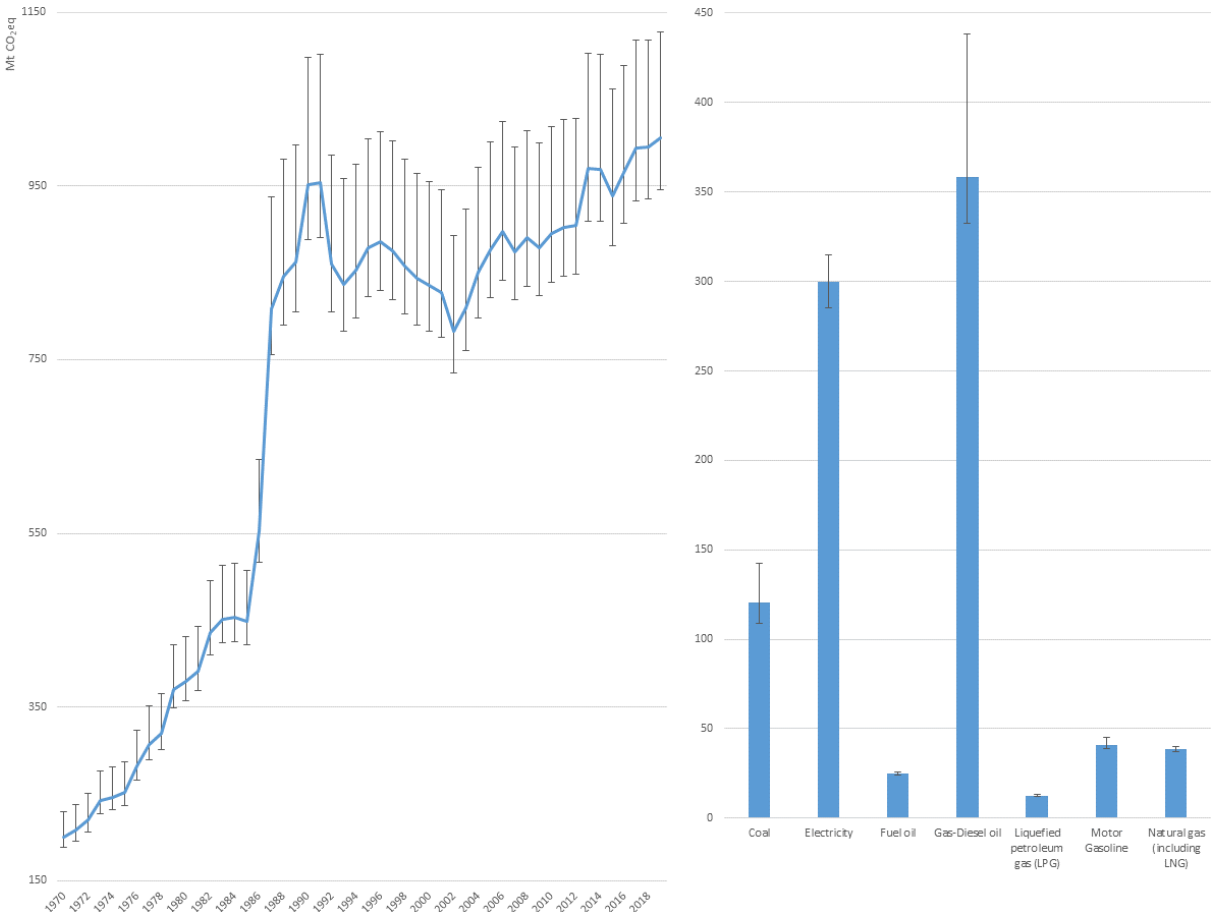
Figure 3. Trend in global GHG emissions (from 1990 to 2019) and global GHG emissions from energy use in agriculture by energy source (average 1990–2019) with uncertainty ranges. Source: FAOSTAT, based on data from IEA and UNSD (2021).